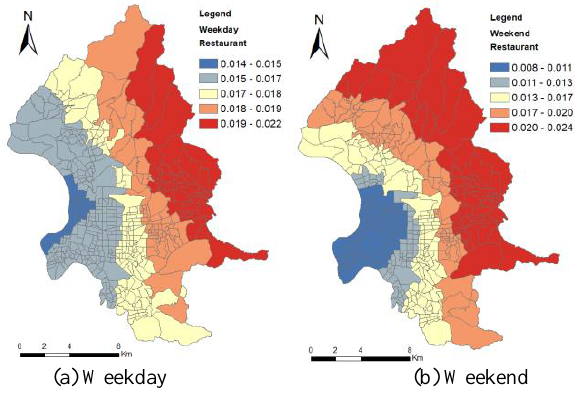
Figure 2. The spatial distribution of restaurant